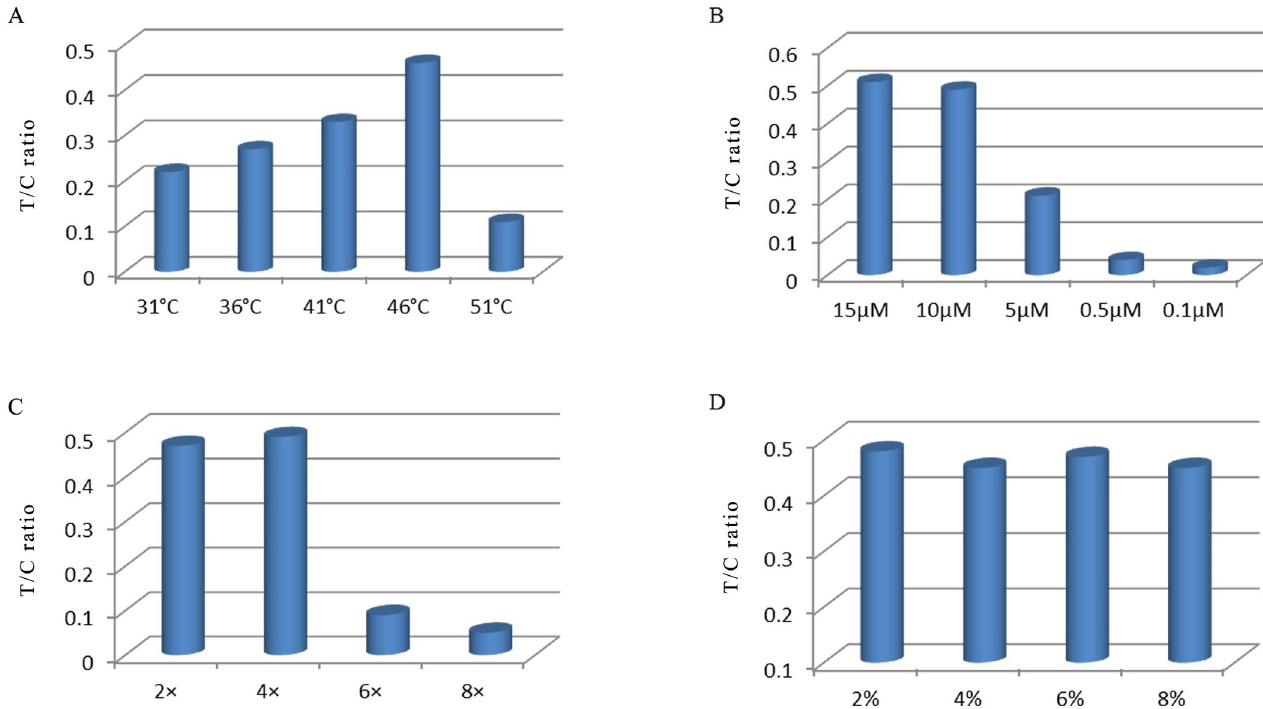
Fig 3. Optimization of hybridization conditions. (A) Effect of the hybridization temperatures on the T/C ratio of LFBA, (B) effect of the probe concentration on the T/C ratio of LFBA, (C) effect of the SSC concentration on the T/C ratio of LFBA and (D) effect of the BSA concentration on the T/C ratio of LFBA.